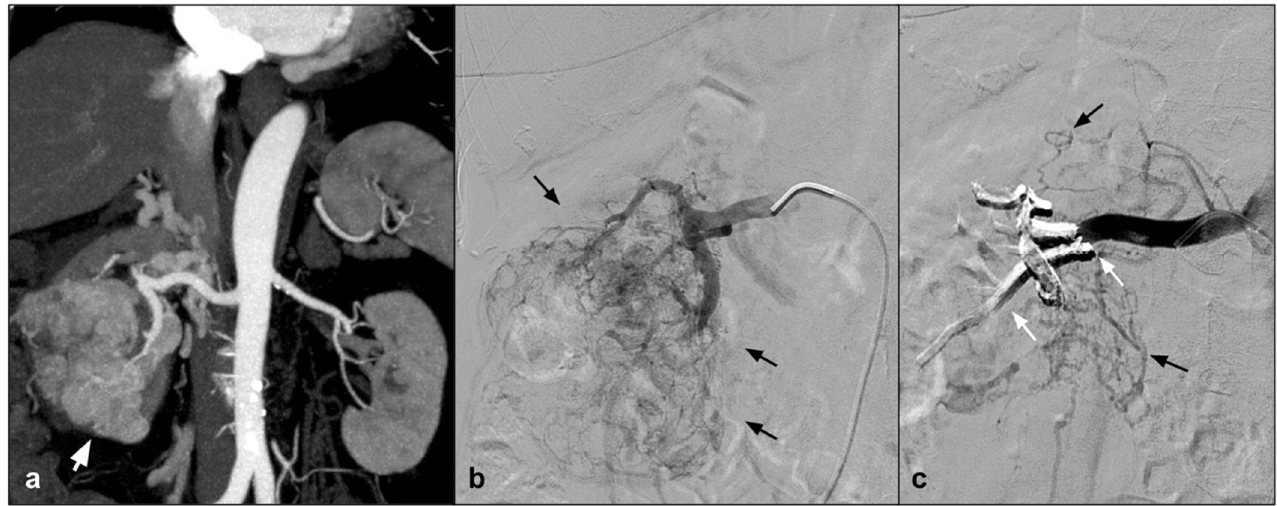
Figure 5. ( a ) Coronal CTA MIP highlights a large angiomyolipoma of the right kidney lower third (white arrow). ( b ) DSA performed with a direct injection in the right renal artery confirms the lesion with an abnormal arterial vascularization (black arrows). ( c ) A post procedure DSA check demonstrates the presence of the Squid 34 cast which completely occludes the tributary arteries of the lesion (white arrows) and preservation of the healthy renal parenchyma (black arrows).